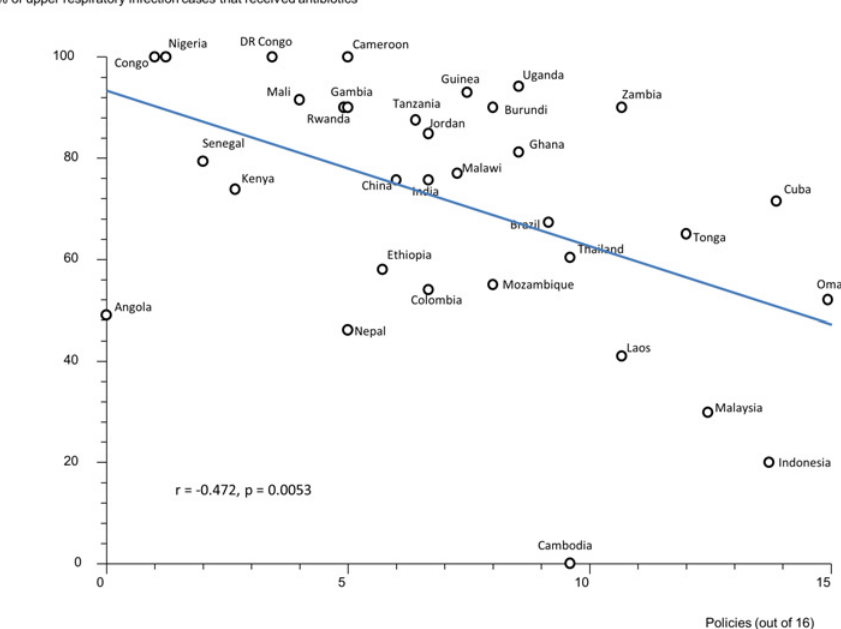
Fig 2. Correlation between the number of implemented policies (out of 16) and the treatment of acute upper respiratory tract infection with antibiotics. Correlation coefficient (r) = -0.472, p = 0.0053. Each data point (circle) represents a country.